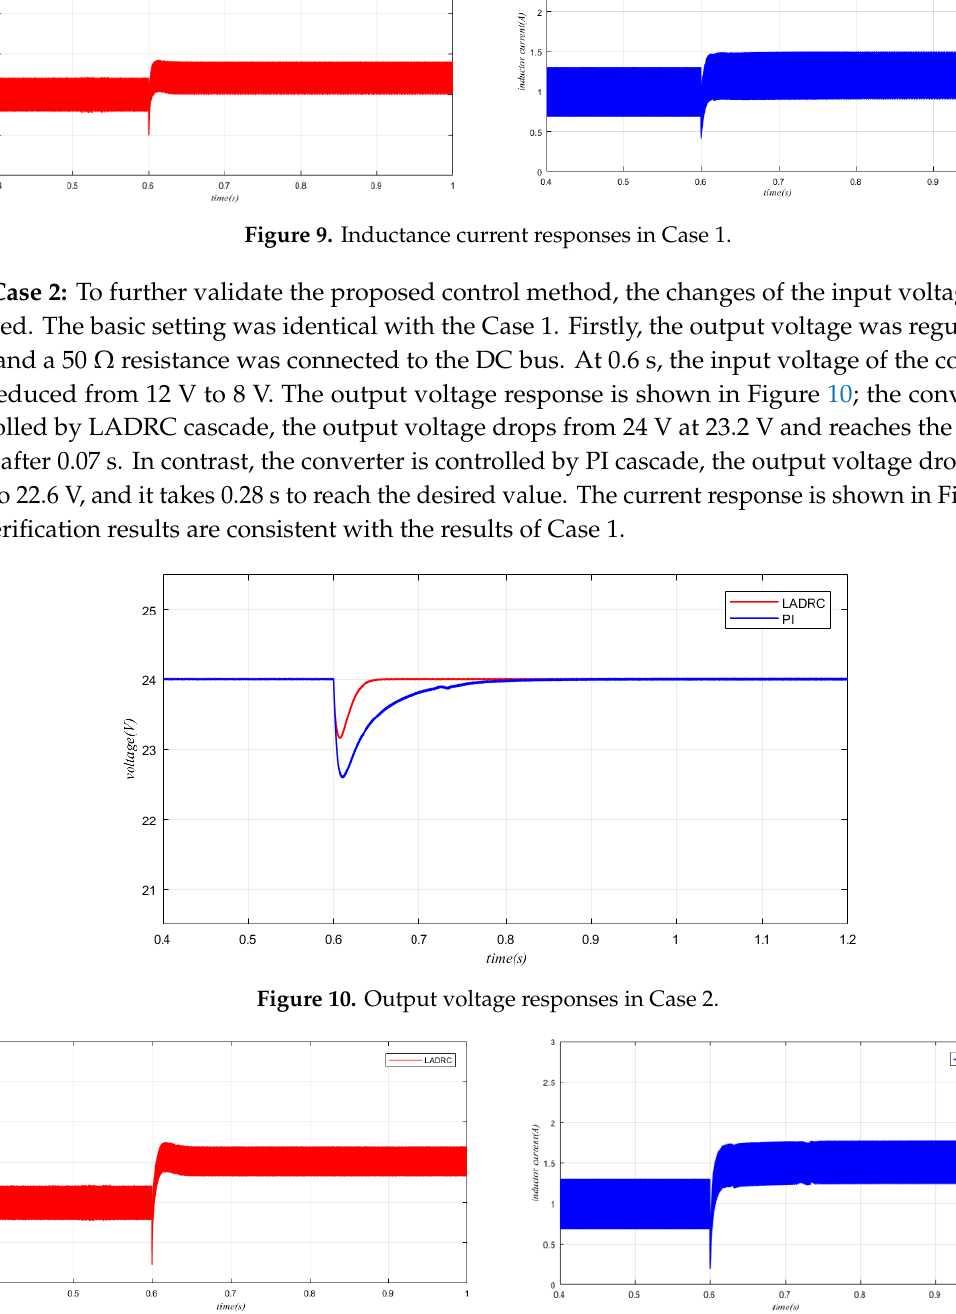
Figure 11. Inductance current responses in Case 2.